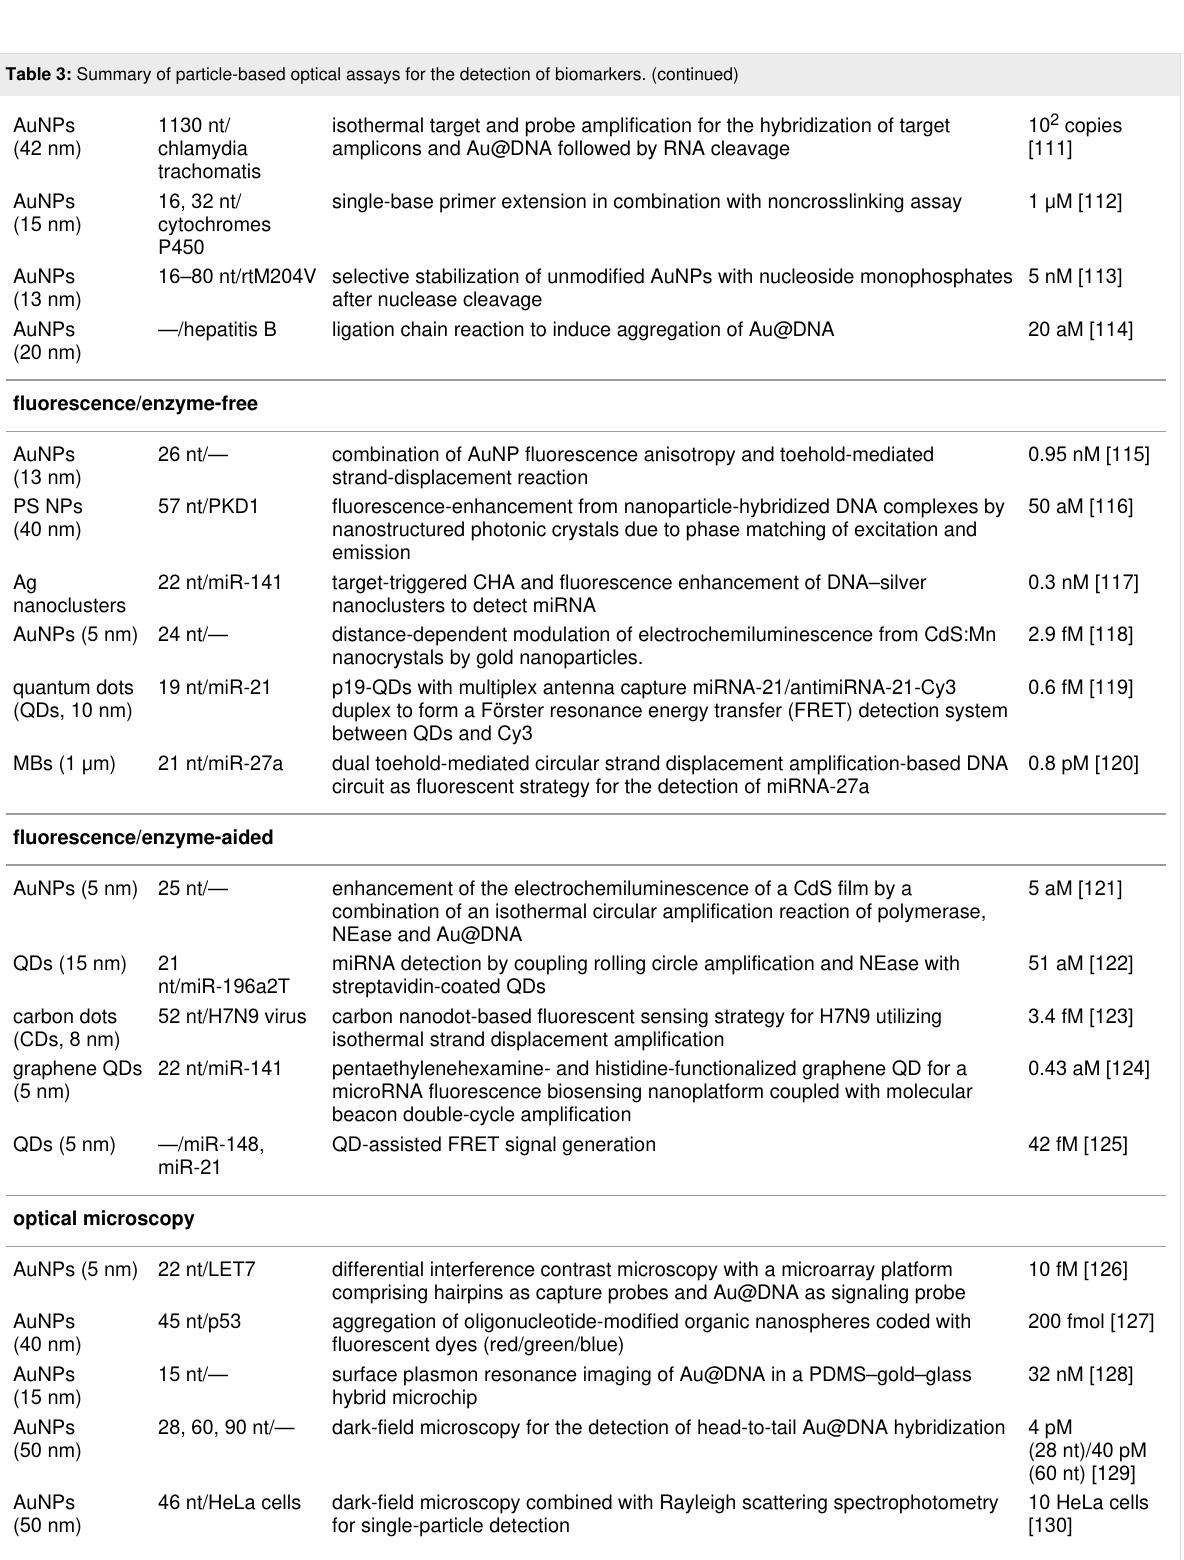
particles of 13 nm. This method, however, had a rather low selectivity and could only differentiate DNA strands containing three or more mismatched